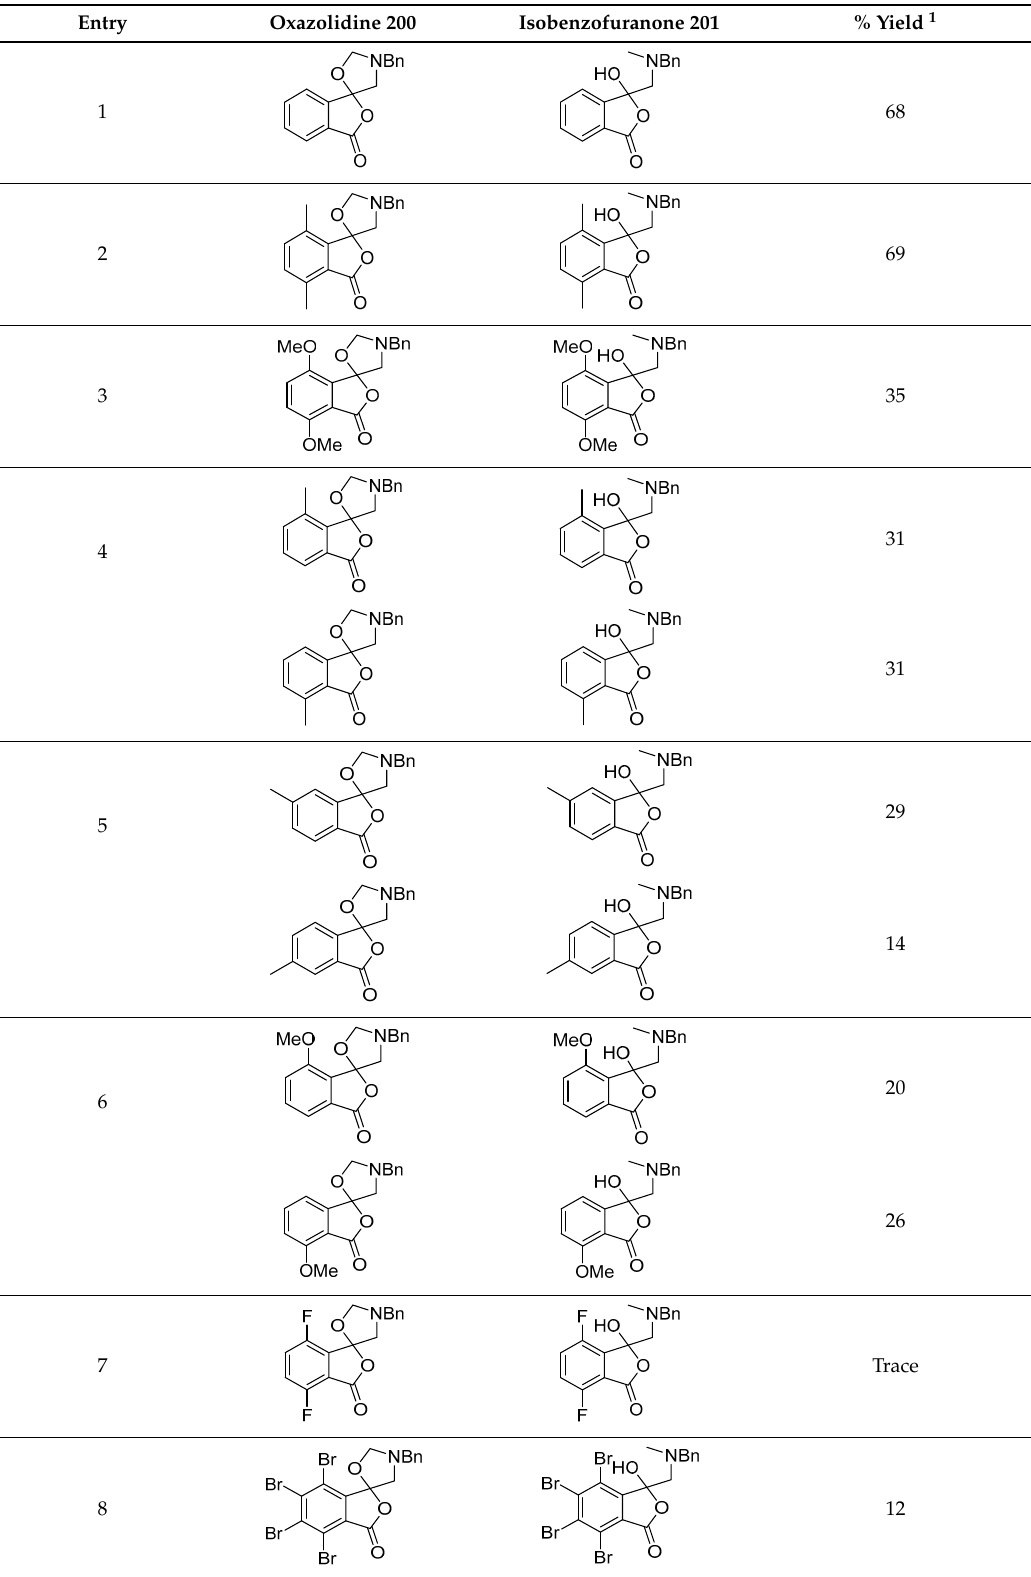
Table 28. Reductive ring-opening of oxazolidines 200 with NaBH 4 1 .